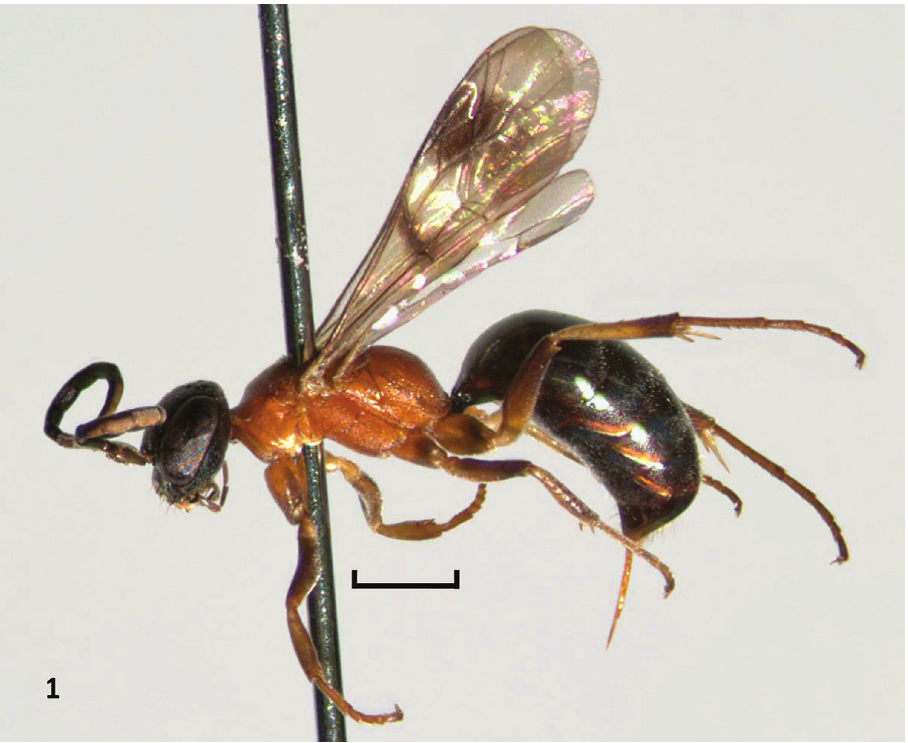
Figure 1. Nipponodipogon orientalis Loktionov, Lelej & Xu, sp. n., female, holotype, habitus, lateral view. Scale bar 1